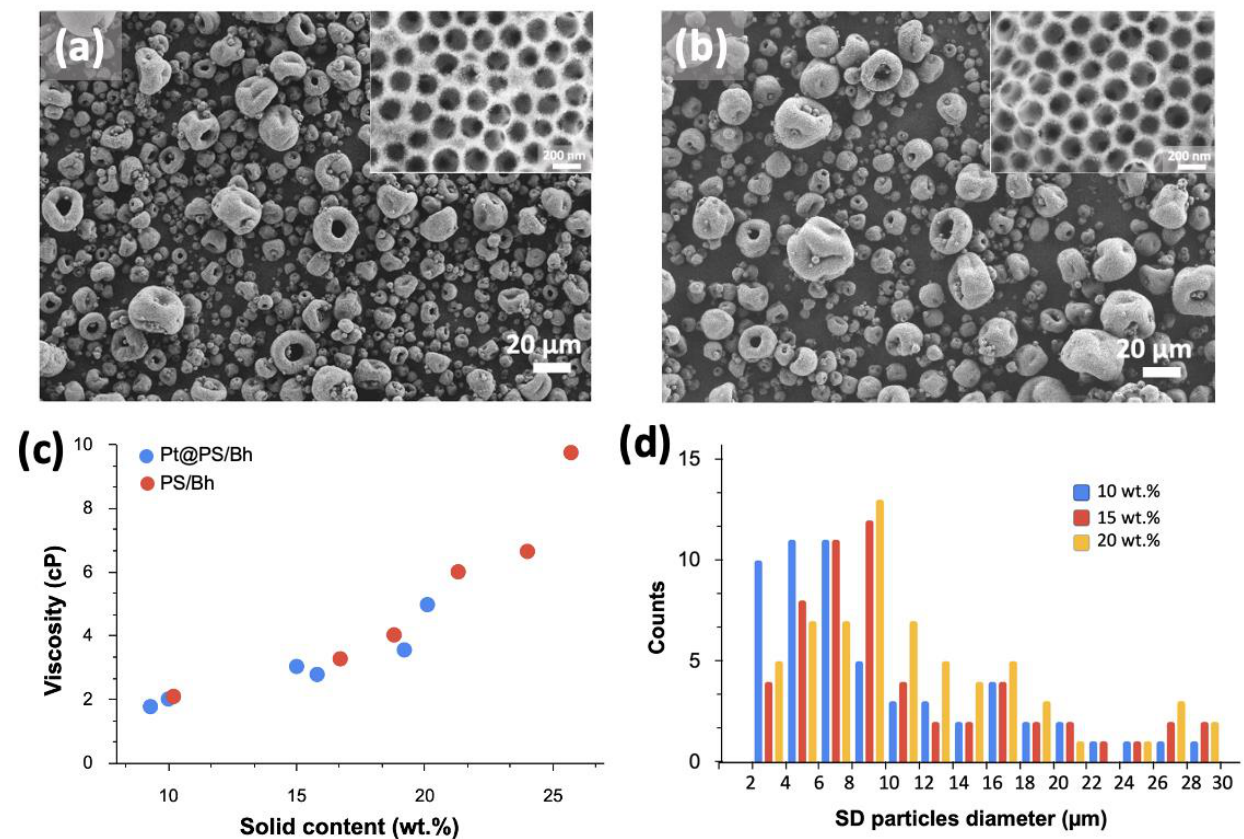
Figure 6. Effect of initial slurry concentration on the viscosity of the SD slurry and resulting SD particles size. ( a , b ) SEM images of SD 0.4Pt/Al 2 O 3 microparticles synthesized using 0.4Pt@PS slurry formulation with 15 wt.% and 20 wt.%, respectively. ( c ) Viscosity of slurries made from different concentrations of precursors. Red dots correspond to slurries formed from unmodified PS (not Pt) with boehmite nanoparticles, while blue dots correspond to 0.4Pt@PS and boehmite formulations. All slurry viscosities were measured at 60 RPM. ( d ) Size and size distribution of SD particles created using different initial slurry concentrations.